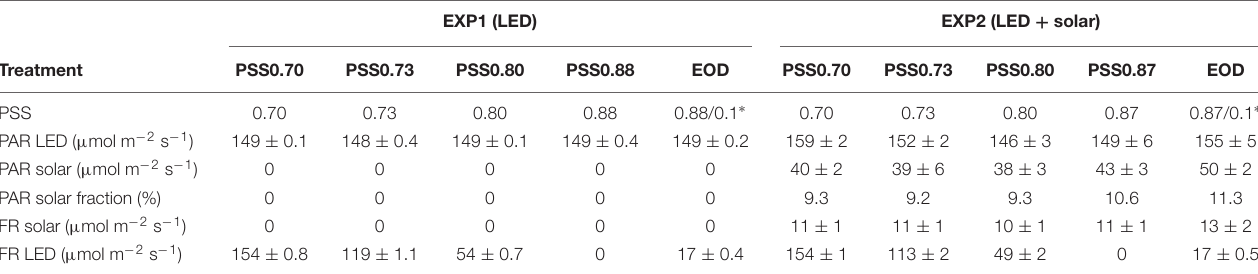
TABLE 1 | LED and solar light intensity (PAR and FR) and calculated PSS values for the five treatments without solar light (EXP1) or with solar light (EXP2).